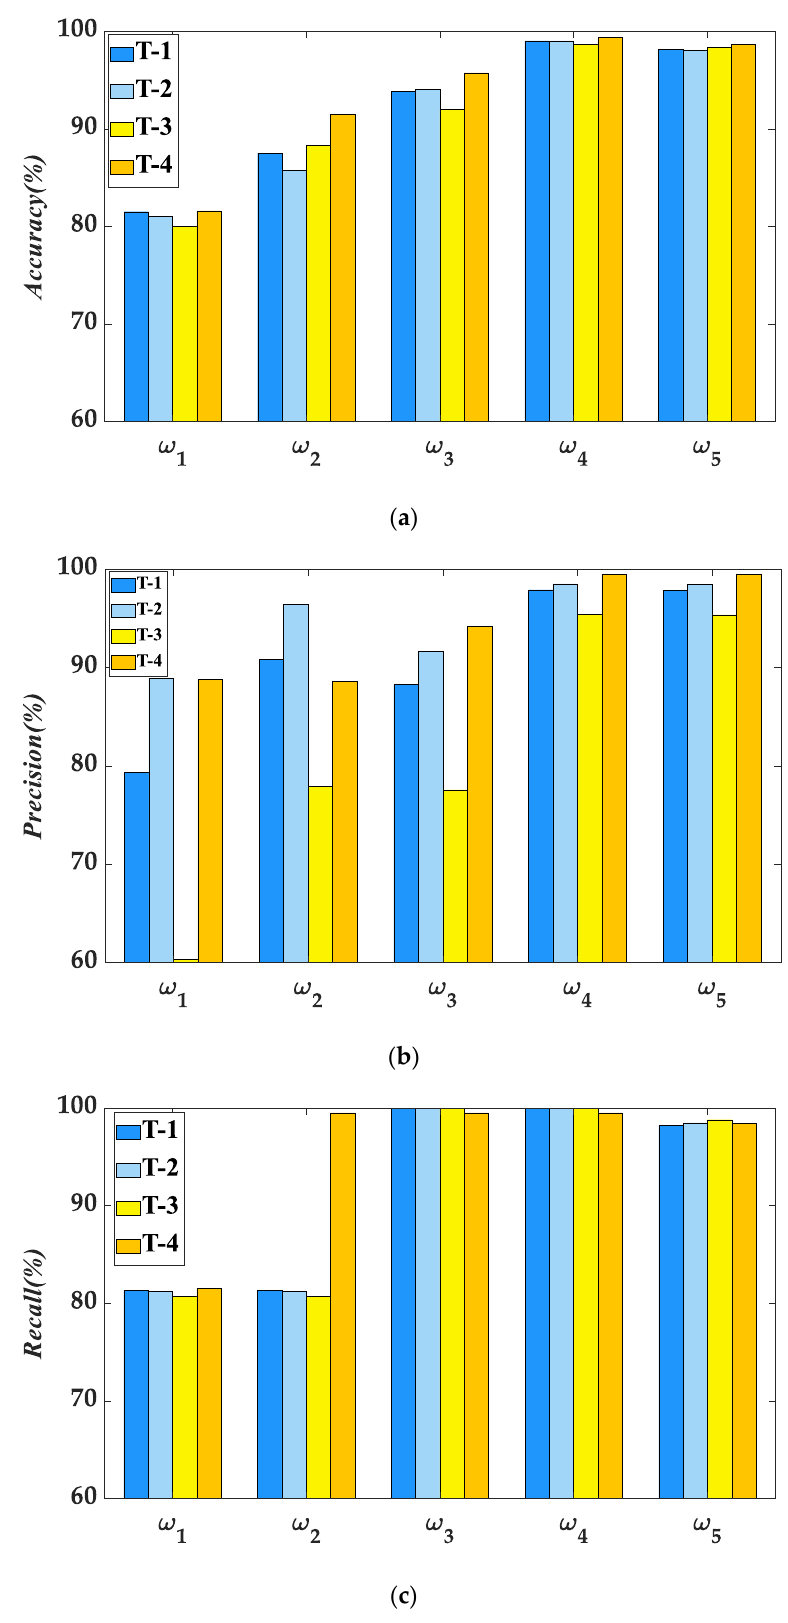
Figure 10. Accuracy , Precision , and Recall values under different 𝜔 : ( a ) Different 𝜔 values of Accuracy values; ( b ) Different 𝜔 values of Precision values; ( c ) Different 𝜔 values of Recall values.